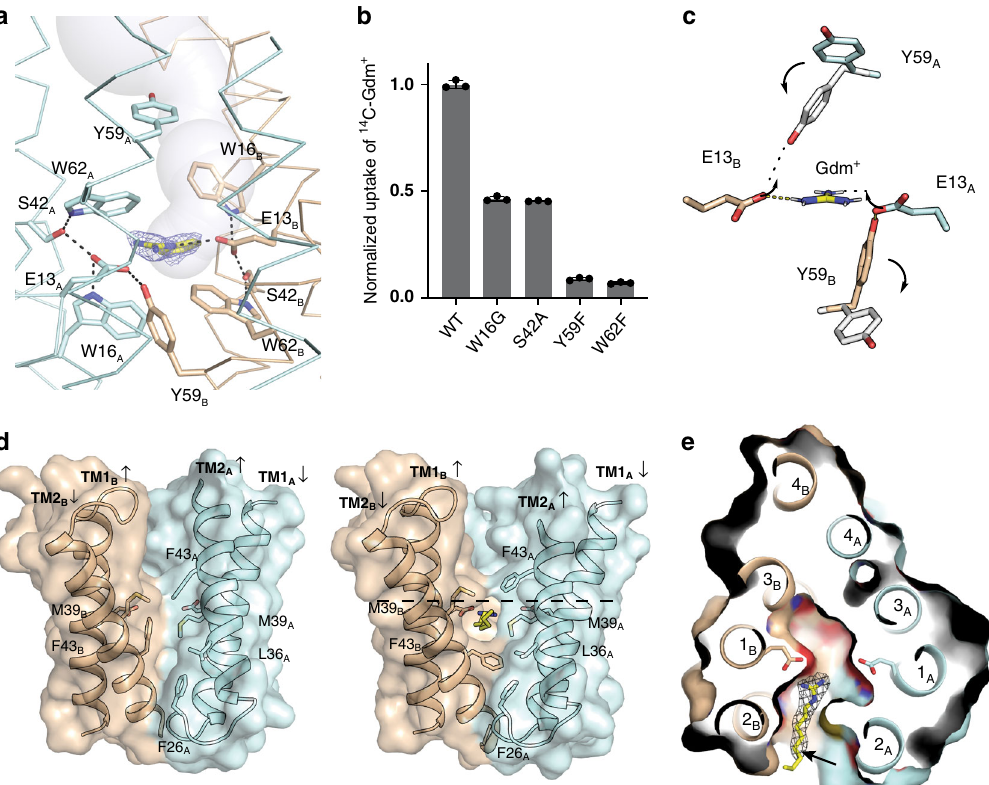
Fig. 4 Substrate binding by Gdx-Clo. a PhenylGdm + binding site. Subunits colored in light blue and tan as in Fig. 3. The aqueous accessible vestibule is shown as a gray surface rendering. Sidechains that coordinate substrate or E13 shown as sticks, and interactions with appropriate distance and geometry for hydrogen bonds are shown as dashed lines. The electron density assigned to phenylGdm + (2Fo-Fc map contoured at 1.3 σ ) is shown as blue mesh. b Uptake of 14 C-Gdm + into proteoliposomes mediated by the indicated mutant. Total uptake is normalized relative to uptake by WT at 10 min. Error bars represent the SEM for three independent replicates. c Illustration of the proposed conformational transition around the transported Gdm + . Colored sidechain sticks are in the positions observed in the structure; white sidechain sticks and arrows show proposed conformational change. d Membrane portal. The structure from Fig. 3 is shown at left, and the octylGdm + bound structure is shown at right. Cartoon is shown with helices 3 and 4 removed for clarity. Sidechains lining the portal, and E13 sidechains, are shown as sticks. OctylGdm + is shown as stick representation, with octyl tail extending toward the viewer. Dashed line indicates the level at which the protein is sliced in panel ( e ). e Top-down view of Gdx-Clo surface and helices with octylGdm + , sliced at approximately the midpoint of the membrane. E13 sidechains are shown as sticks. Experimental 2Fo-Fc density for the ligand, contoured at 1.8 σ , is shown as gray mesh. The arrow indicates C 5 of the octyl substituent. Agmatine and arginine bear amino groups at this